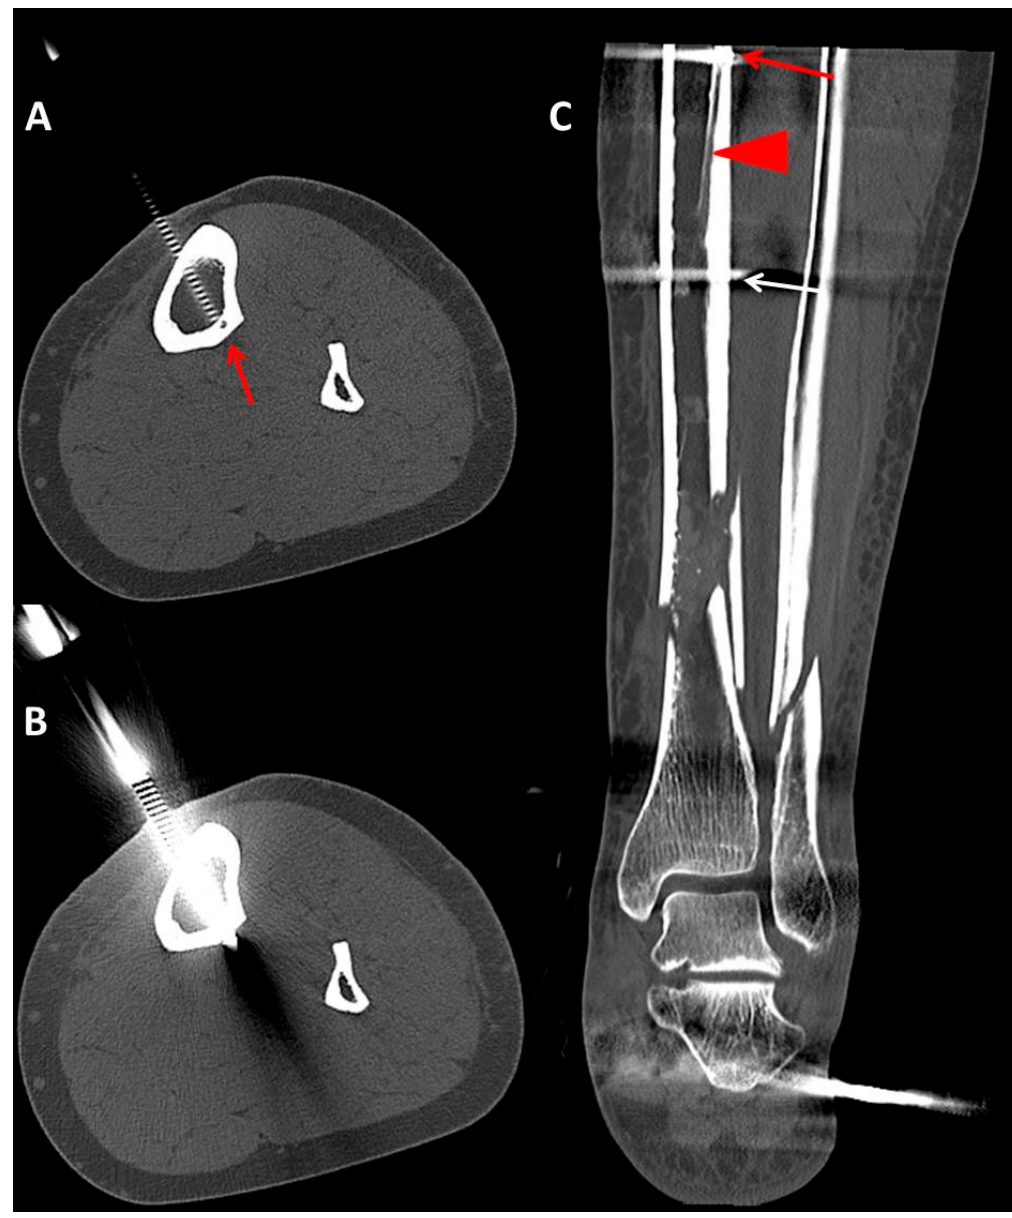
Figure 3. Subsequent axial ( A , B ) reformatted images in the bone window showing complete disruption of the tibial nutrient artery (TNA) canal (red arrow) by the proximal pin of an ankle spanning external fixator in the setting of a distal lower extremity fracture. ( C ) Coronal reformatted image illustrating both proximal (red arrow) and distal (white arrow) pins of the external fixator. The inner foramen of the TNAC is shown (tip of the red triangle). The outer foramen is not illustrated. Note that the proximal pin is applied in concordance with published surgical guidelines (i.e., bicortical and anteromedial application).